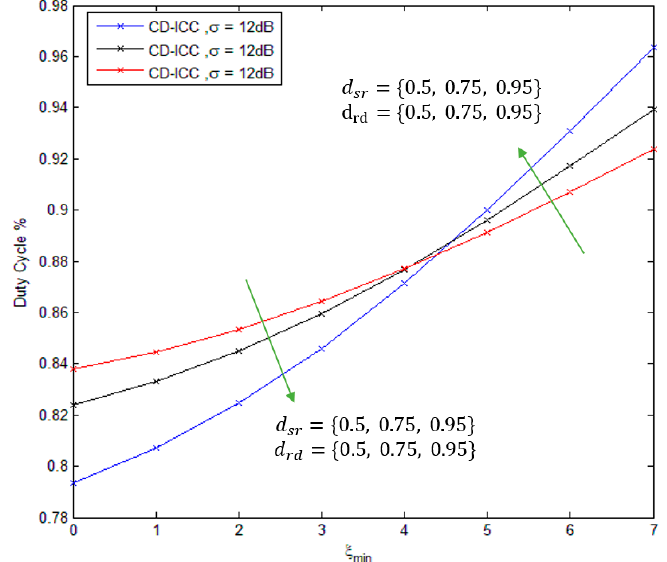
Figure 8. Duty cycle of CD-ICC with ξ min . In all cases, d sd is 1, σ is 12 dB, T sleep is 40 s and ρ is